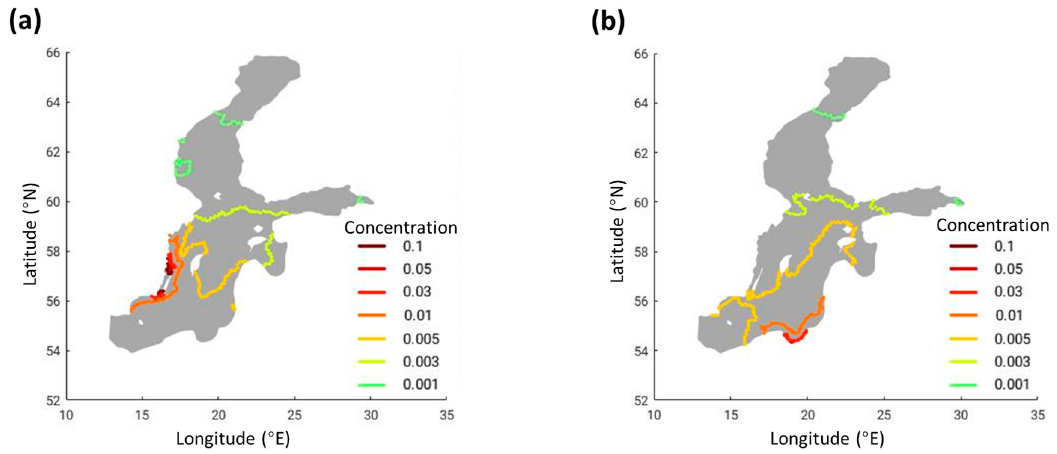
Figure 7. Isolines of maximum solute concentration over the simulation period in the equivalent release scenario. ( a ) Kalmar County coast case; ( b ) Vistula River coast case.